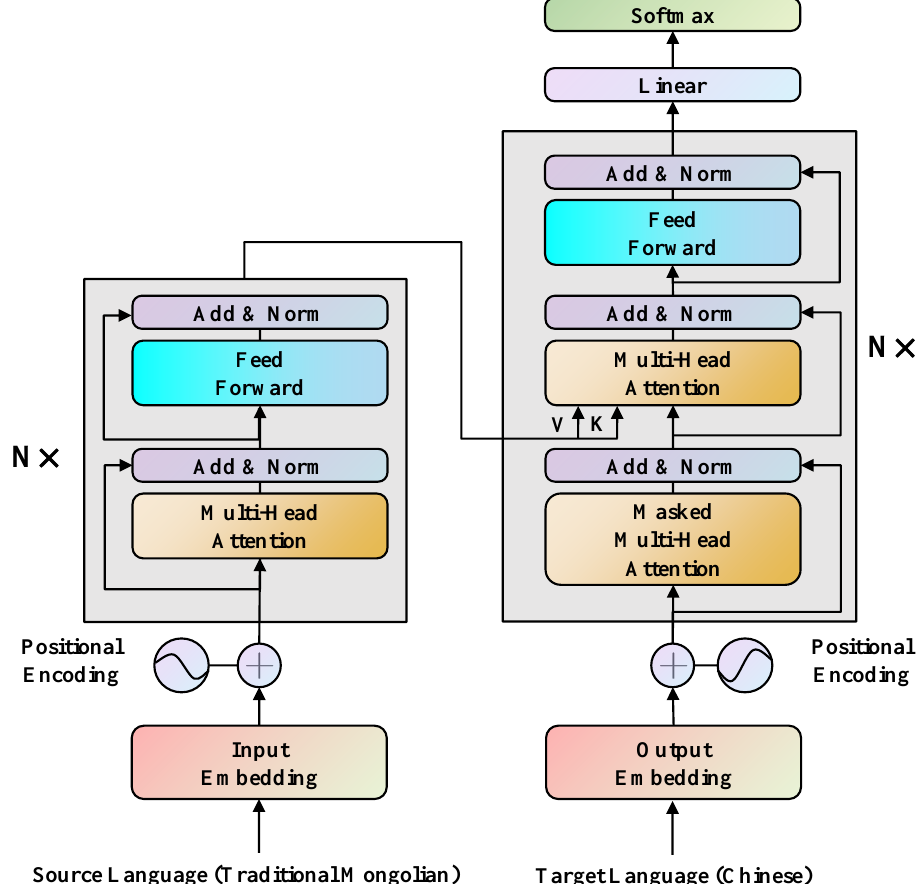
Figure 1. Construction of the Transformer